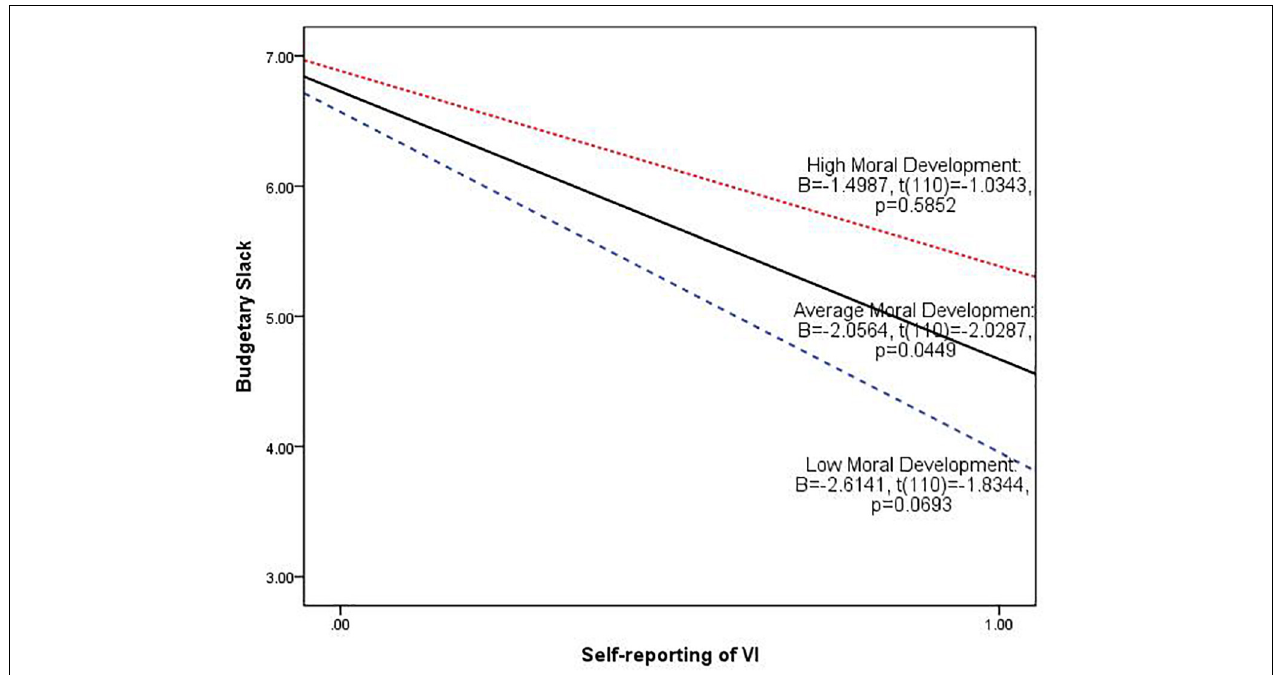
FIGURE 5 | Plot of the predicted value of budgetary slack at self-report of VI at low, average, and high levels of moral development. The average, low, and high level of moral development are defined according to the mean, mean + 1.0 standard deviation, and mean − 1.0 standard deviation of moral development. The slope of each plotted line is the simple slope of self-reporting of VI at the various values of moral